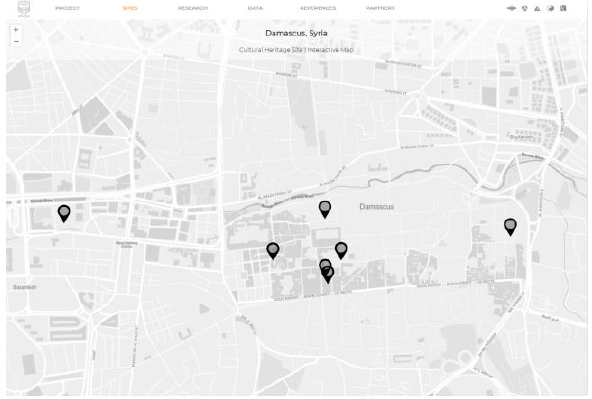
Figure 11 – Interactive Map of Damascus